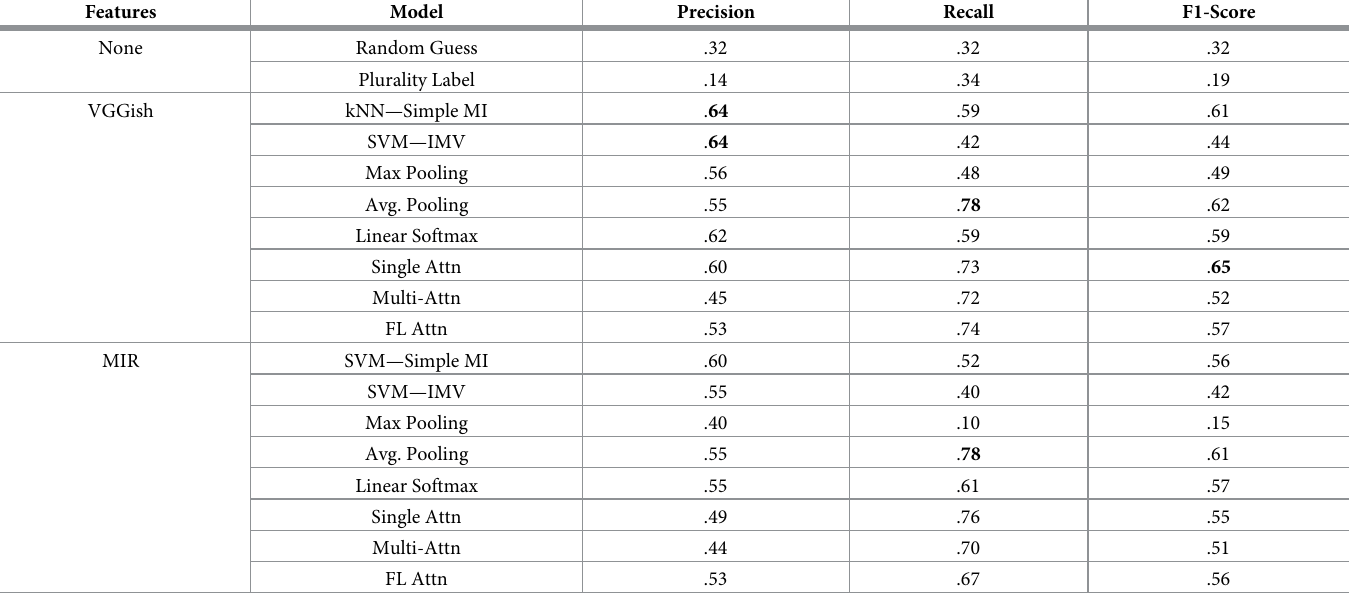
Table 4. Classification results on the 110-film dataset. Performance metrics using leave-one-out cross-validation for each cue-level feature model are reported. IMV stands for Instance Majority Voting; FL Attn for Feature-Level Attention. Simple MI and IMV results represent performance with the best base classifier (kNN, SVM, and random forest were tried). All models reported mean-averaged precision significantly better than the random guess baseline ( p < .01), as given by a paired t-test. Features Model Precision Recall F1-Score None Random Guess .32 .32